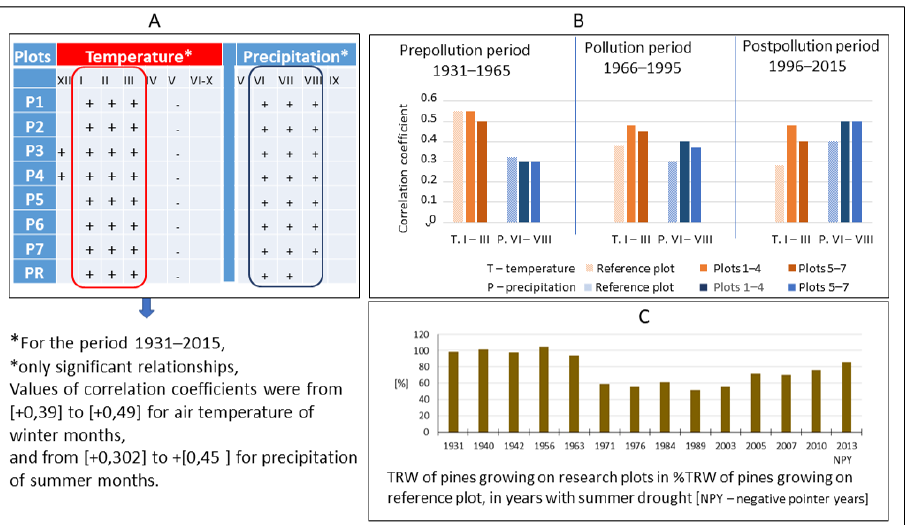
Figure 12. Climate—growth relationships for Scots pine growing on study plots. ( A )—Results of correlation and response analyses for index pine chronologies from study plots (the values of correlation coefficients in Supplementary Material Figure S2); ( B )—correlation coefficients between index chronologies, and winter temperature and summer precipitations, for different period; ( C )—Tree-ring width of Scots pines growing on research plots (plots 1–4) in %TRW of Scots pine growing on reference plot, only years with extreme drought.